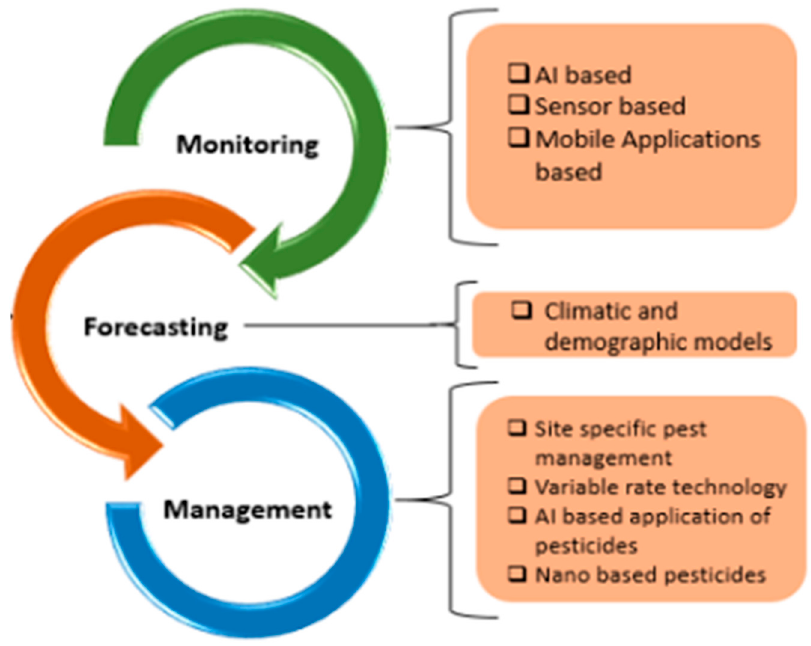
Figure 1. Precision Pest